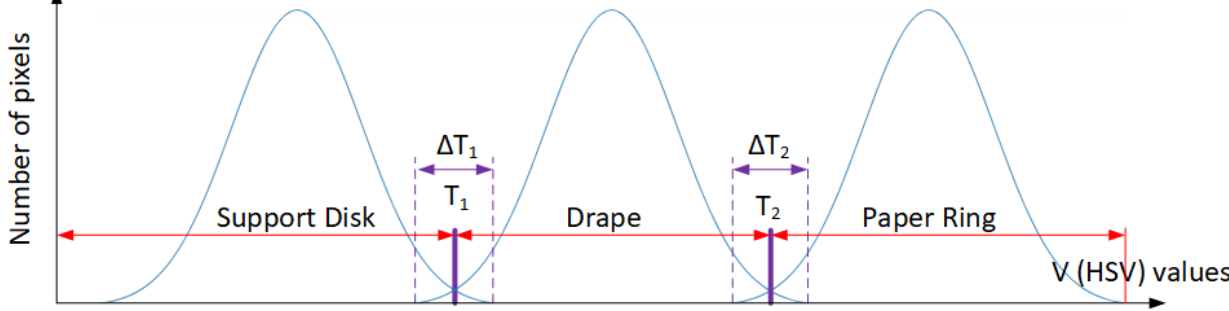
Figure 2. Obtaining histogram of drape image.